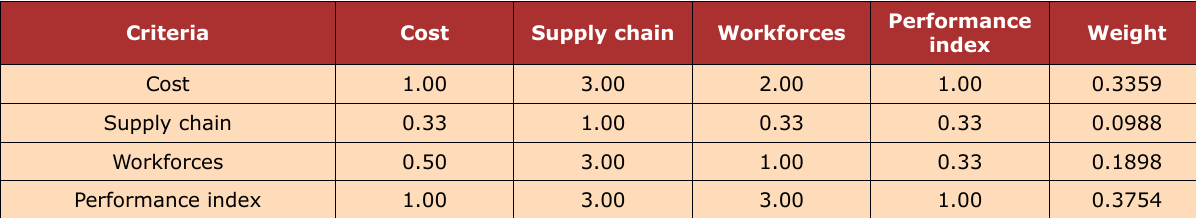
Table 8. Pair-wise comparison matrix for four